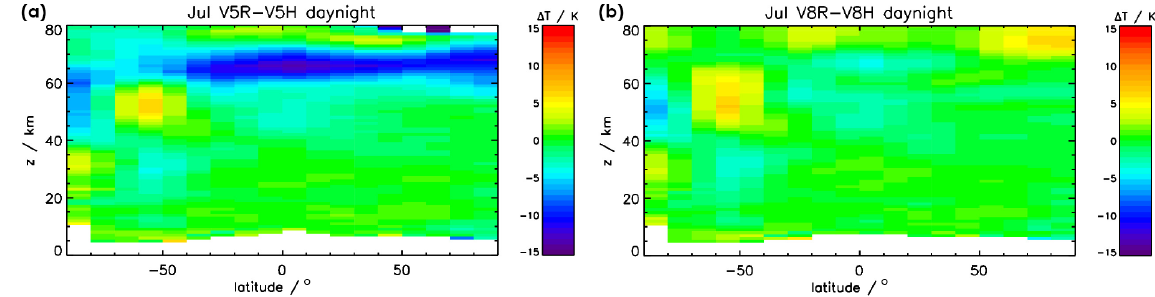
Figure 8. Difference between reduced-resolution (July 2009) and full-resolution (July 2003) monthly mean data for V5 (a) and V8 (b) .